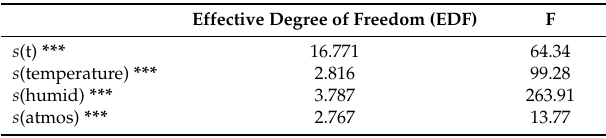
Table 6. Approximate significance of smooth